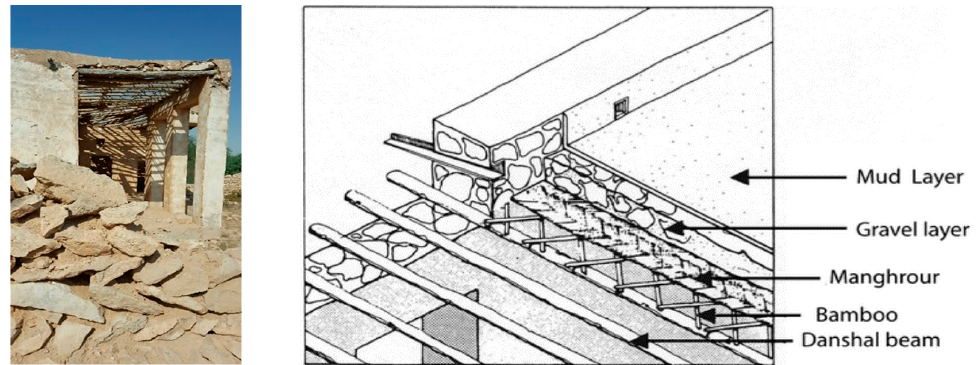
Figure 16. The left picture shows the use of colonnade that shade; additionally, it illustrates the roof structure. The right picture shows a detail of the roof and wall structural system. After Al-Kholaifi, [25], cited in [27].